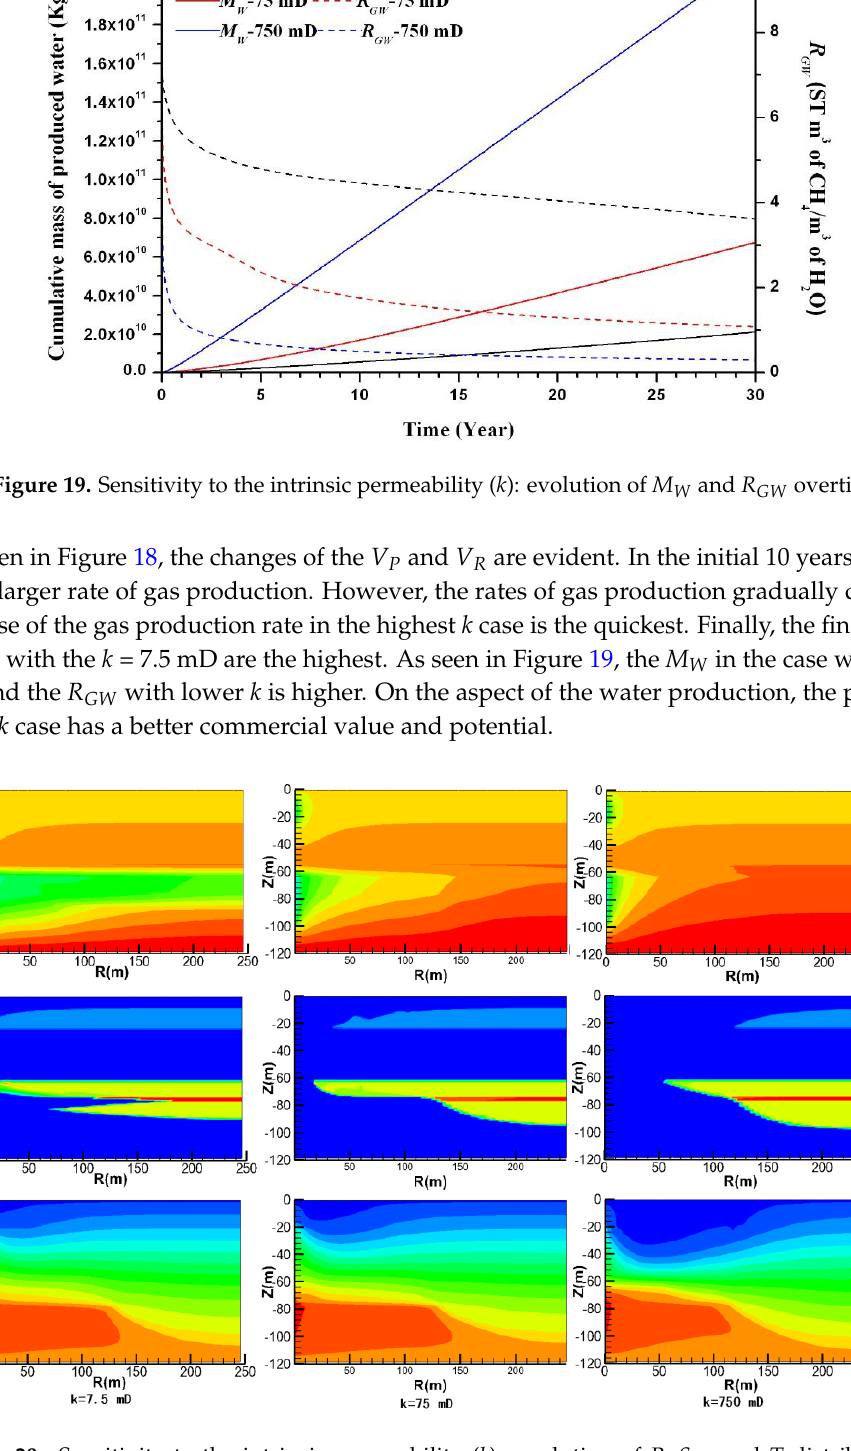
H , and T distribution at